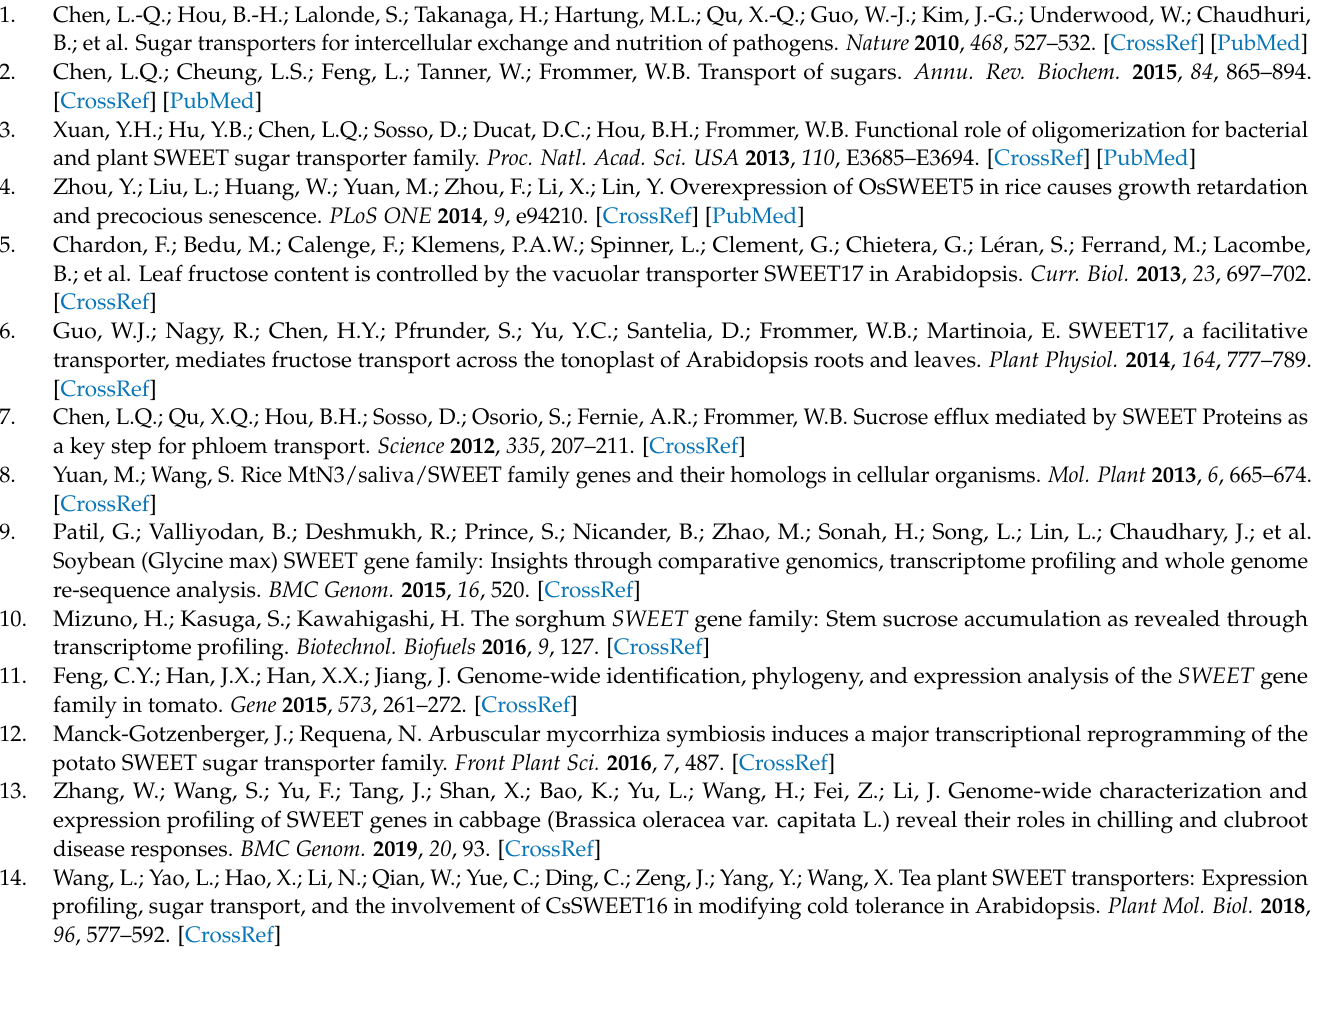
25 RcSWEET proteins; Table S1: Primers used in this study; Table S2: Nucleotide sequences of 25 RcSWEET genes; Table S3: Amino acid sequences of 63 SWEET proteins from three species; Table S4: Estimated Ka/Ks ratios of the duplicated RcSWEET genes; Table S5: The numbers of predicted cis-elements in the promoters of 25 RcSWEET genes; Table S6: Transcriptome sequencing data of RcSWEET genes in different tissues (PRJNA546486); Table S7: Transcriptome sequencing data of RbSWEET genes in leaves and shoots during cold